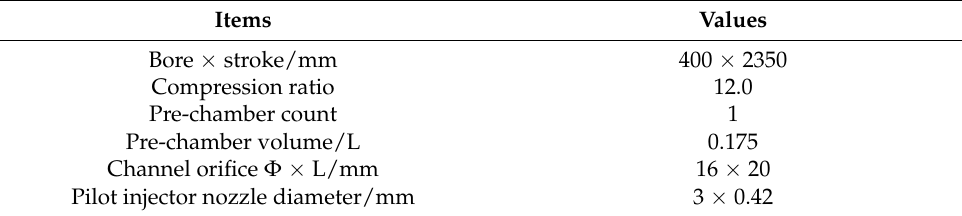
Figure 1. ( a ) Configuration of the dual-fuel marine engine, ( b ) close-up of the pre-chamber and pilot spray path. Table 1. Engine specifications.